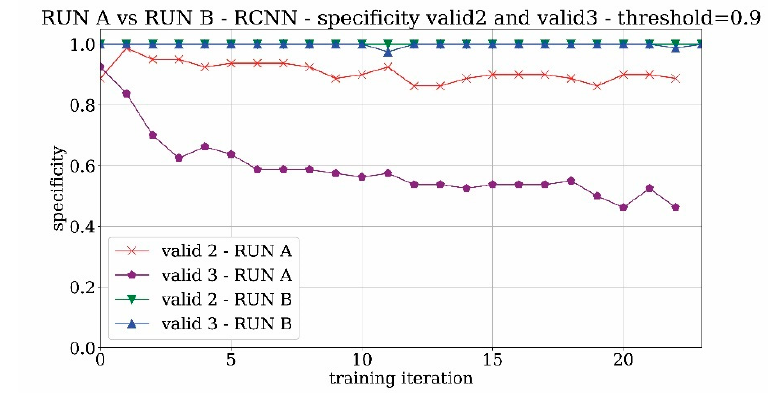
Figure 11. Specificity trend of RUN A and RUN B with valid 2 and 3, and threshold 0.9.